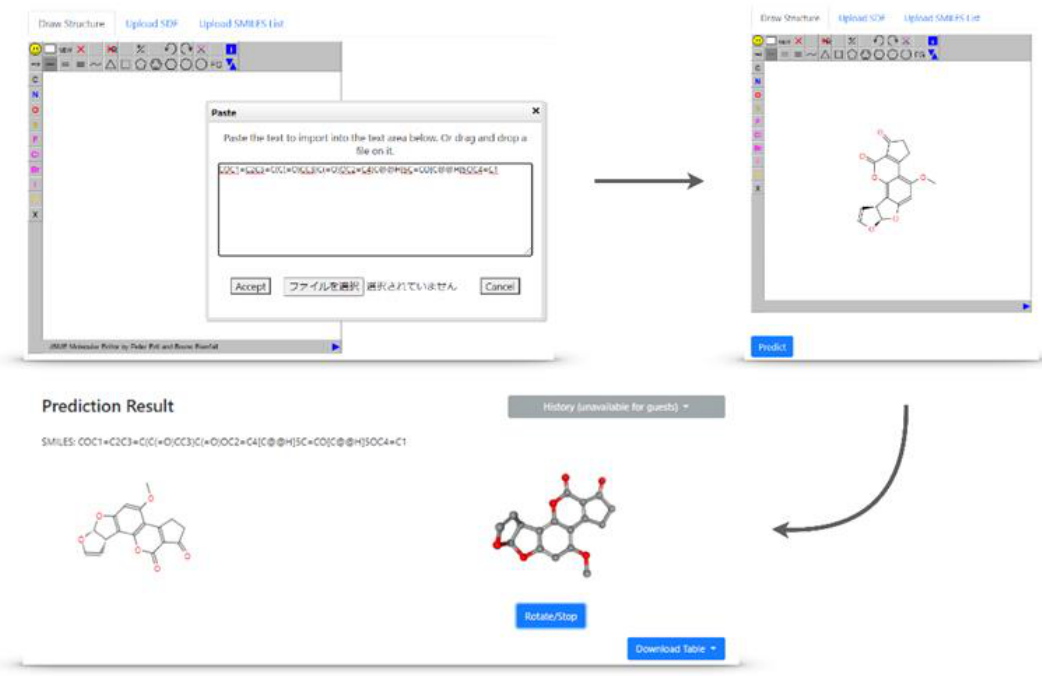
Figure 5. The platform screens of Toxicity Predictor.